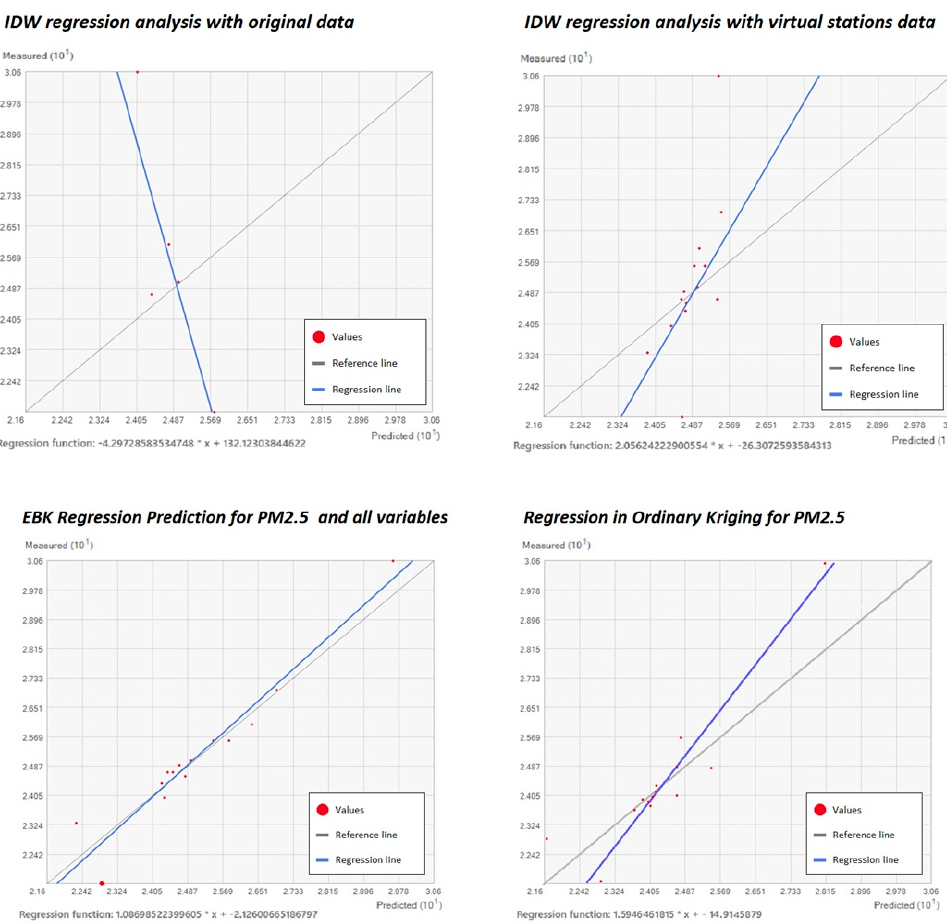
Figure 10. Errors for PM 2.5 in the different interpolation processes.